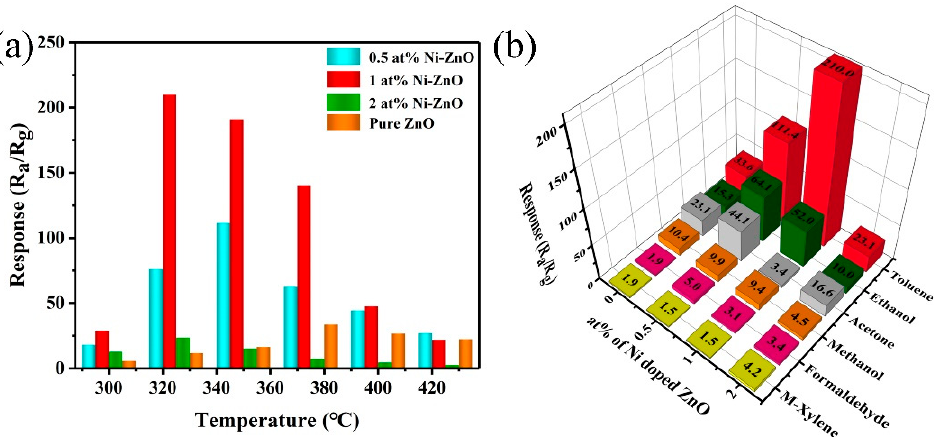
Figure 7. ( a ) The response of the four gas sensors to 100 ppm toluene at different temperatures. ( b ) The selectivity of the four gas sensors to 100 ppm different VOC gases at their optimum operating temperature.